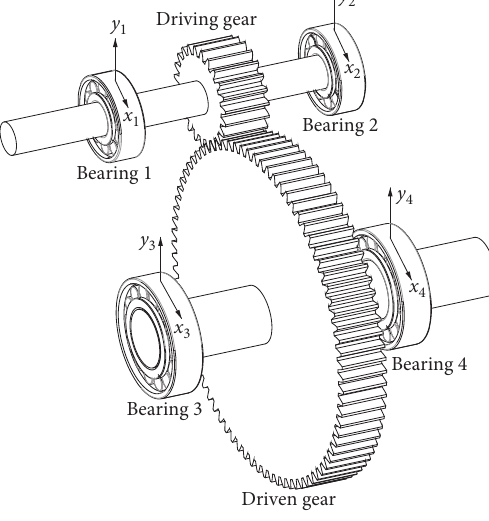
Figure 6: Distribution and serial number of bearings. Table 5: Multisource information of the gear-rotor-bearing system.